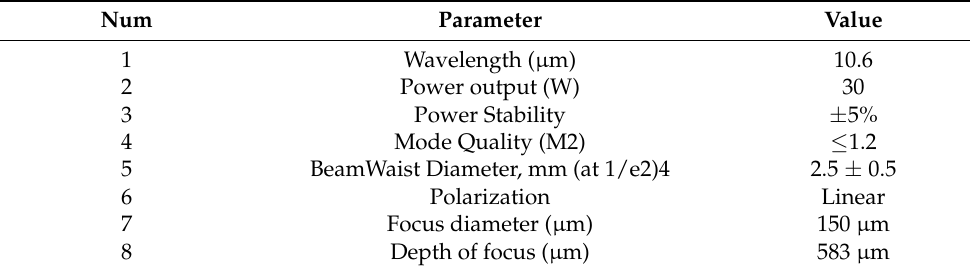
Table 1. Laser and optical path parameters.